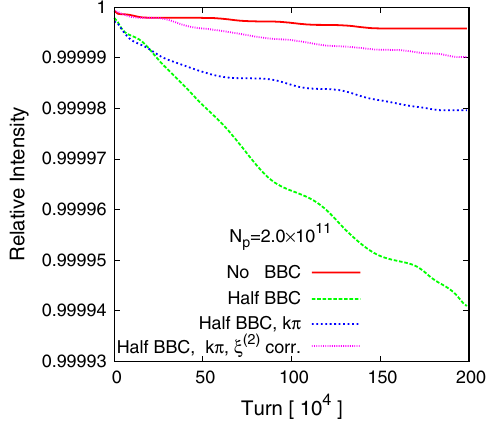
FIG. 15. Initial coordinates of 4800 tracked particles (in red) and of the lost particles (in blue). In this example, the proton bunch intensity is 2 : 5 (cid:2) 10 11 . Half beam-beam compensation is used. These 4800 macroparticles represent 270 586 macropar- ticles of a solid 6D Gaussian distribution. After 2 (cid:2) 10 6 turns, 17 macroparticles are